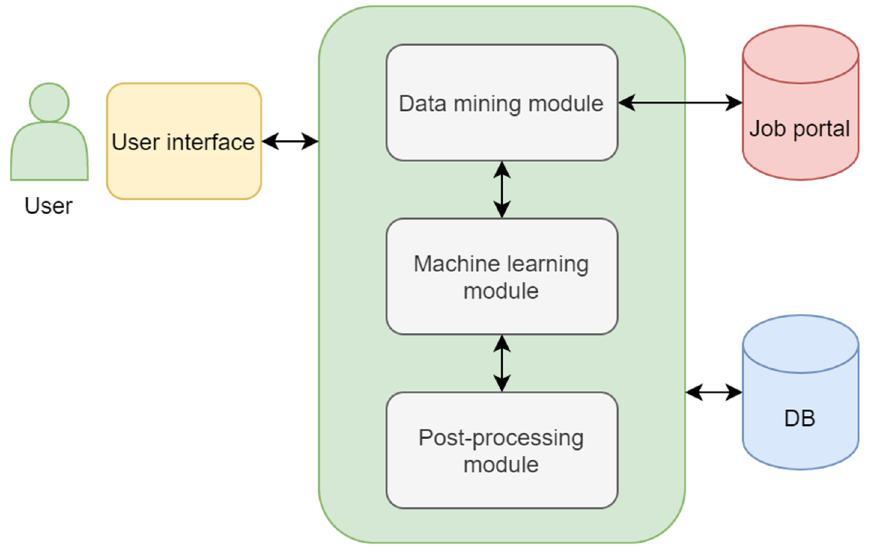
Figure 2. Architecture of the proposed